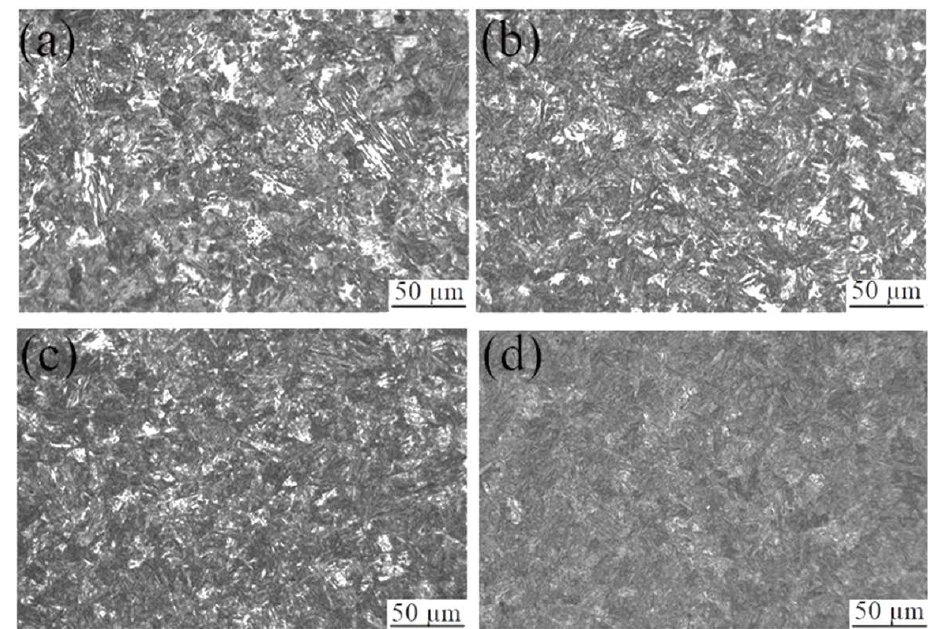
Table 4. Statistics of ferrite ratios in different sub-temperature ranges of Q state.